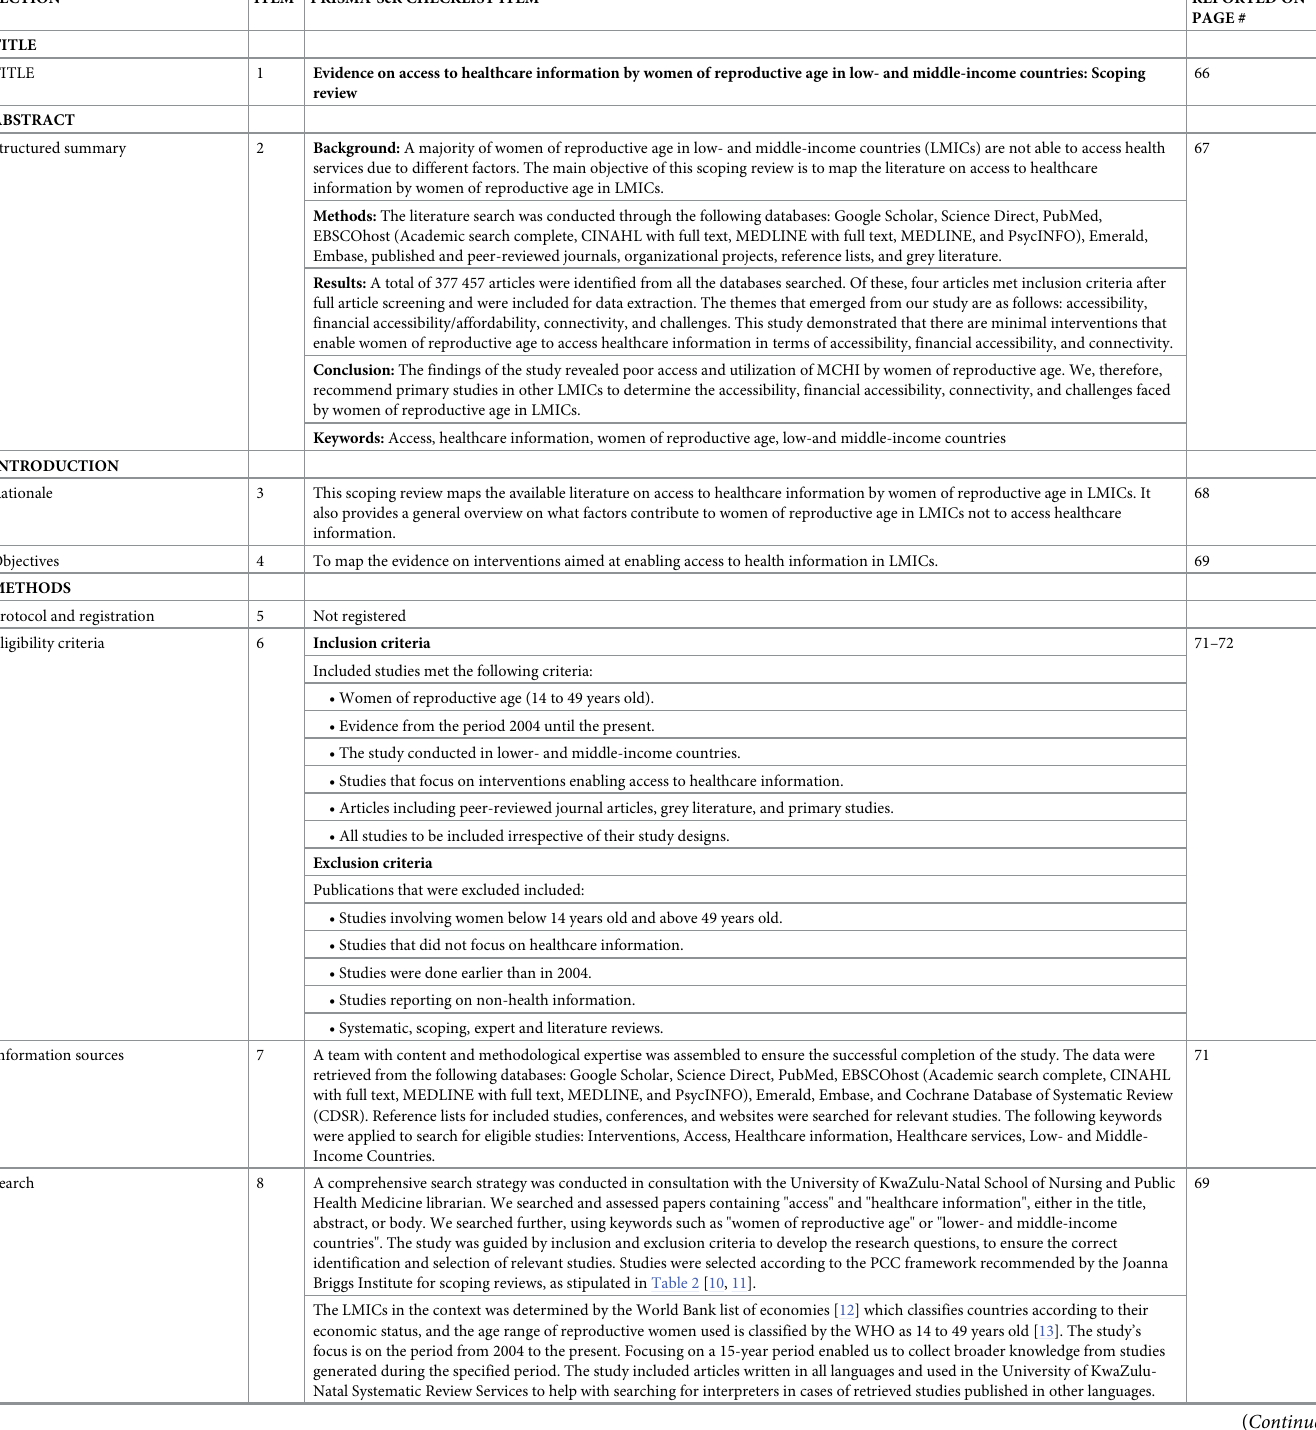
Table 1. Preferred reporting items for systematic reviews and meta-analyses extensions for scoping reviews (PRISMA-ScR) checklist.